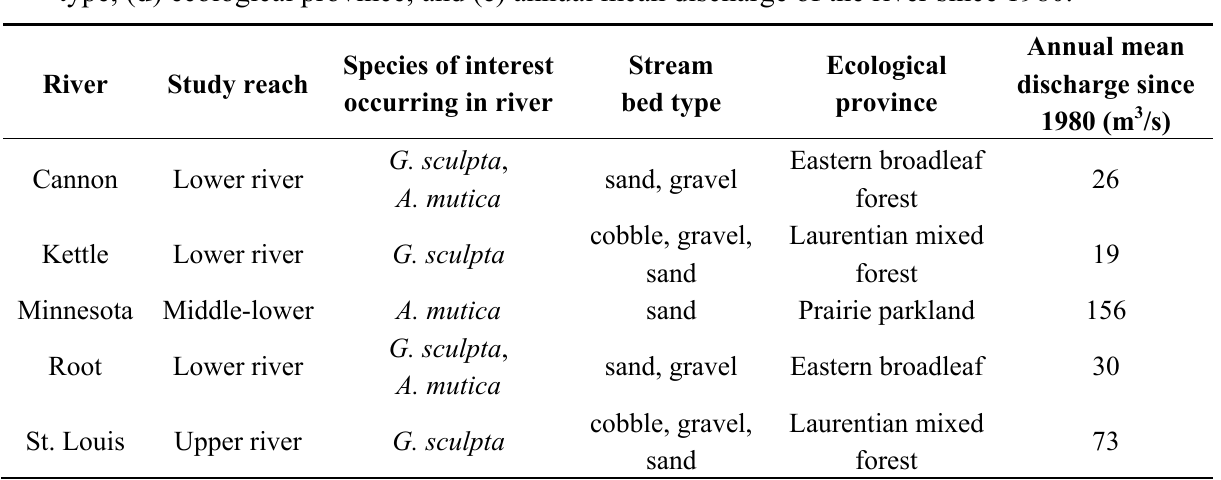
Table 1. Characteristics of study rivers. ( a ) location along river; ( b ) presence of wood turtle ( G. sculpta ) and smooth softshell ( A. mutica ) known to exist in river; ( c ) stream bed type; ( d ) ecological province; and ( e ) annual mean discharge of the river since